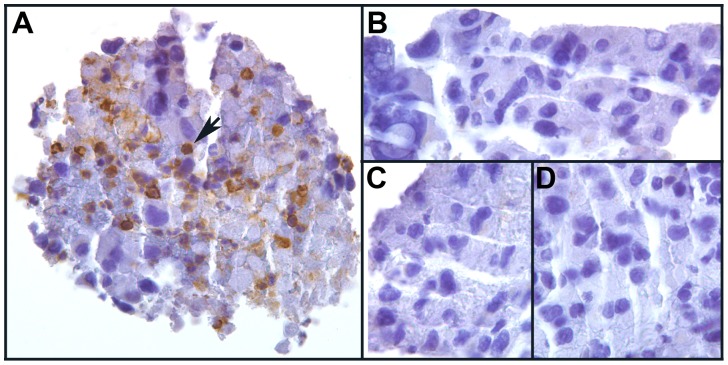
A section of the MH3 melanoma brain metastasis stained for LCA/CD45 (brown chromogen) and counterstained with hematoxylin (blue).A. An area with brown LCA/CD45-positive leucocytes (arrow) intermixed with blue LCA/CD45-negative cancer cells. B-D. Adjacent areas from the same section containing only blue LCA/CD45-negative cancer cells.